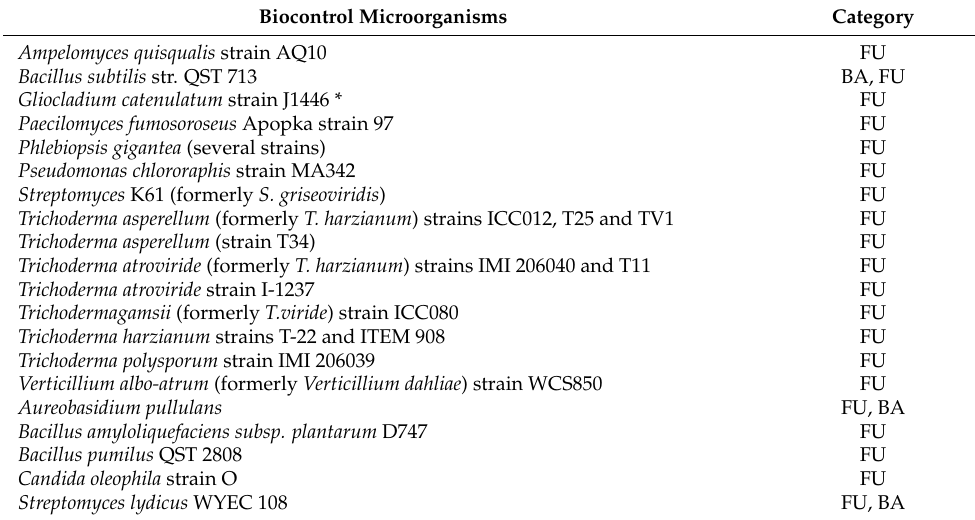
Table 1. List of biocontrol microorganisms approved as active substances in the European Union. Biocontrol